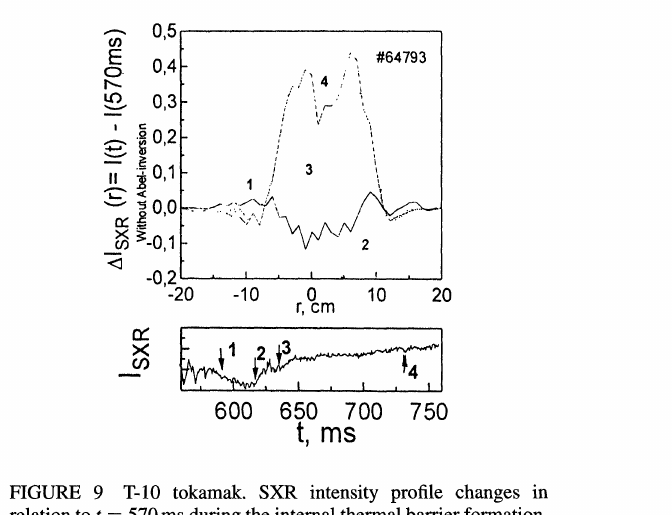
FIGURE 9 T-10 tokamak. SXR intensity profile changes in relation to 570 ms during the internal thermal barrier